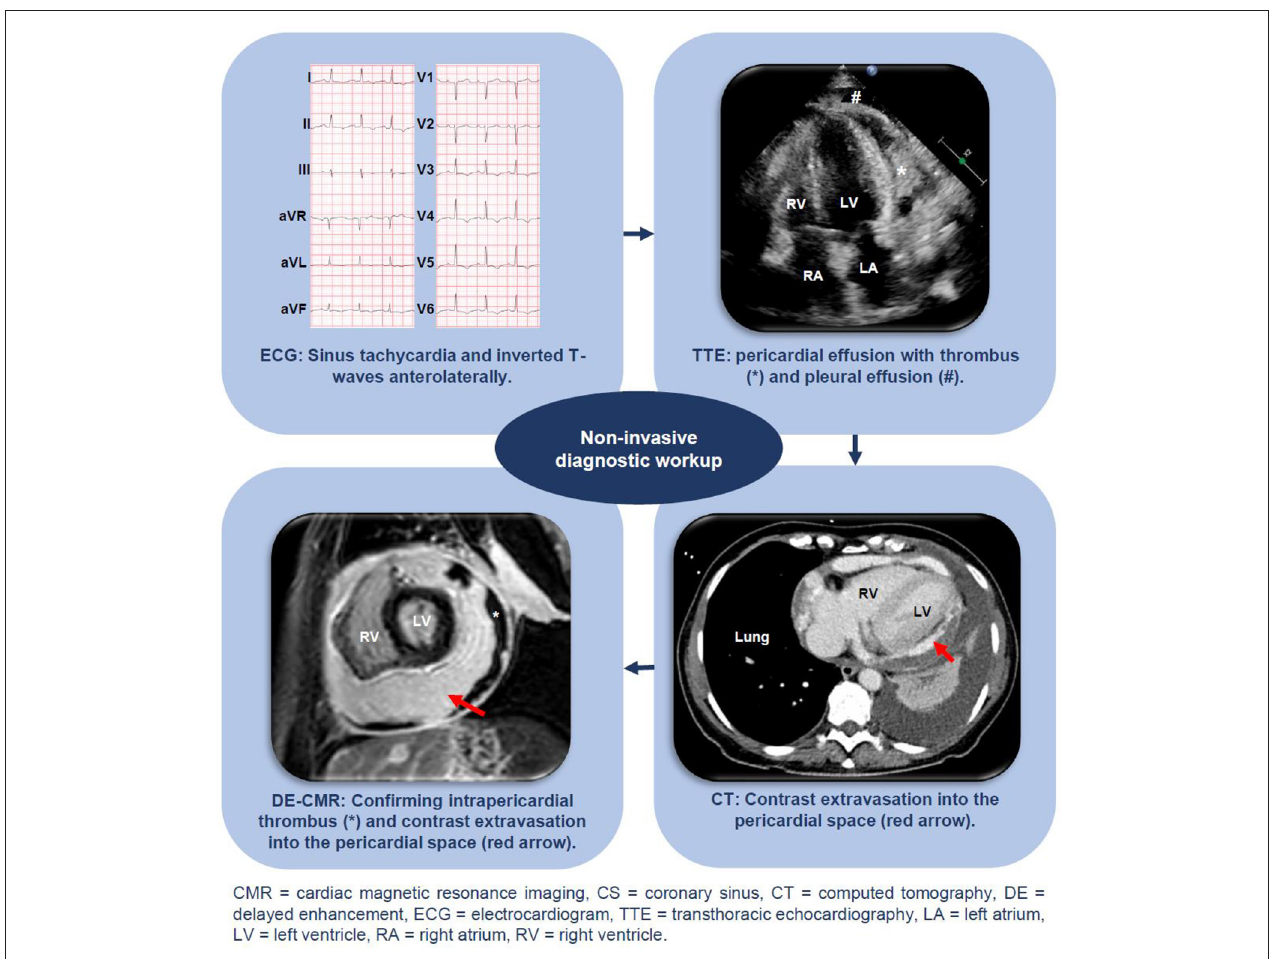
FIGURE 1 | Non-invasive diagnostic workup including ECG, echocardiography, DE-CMR, and CT.